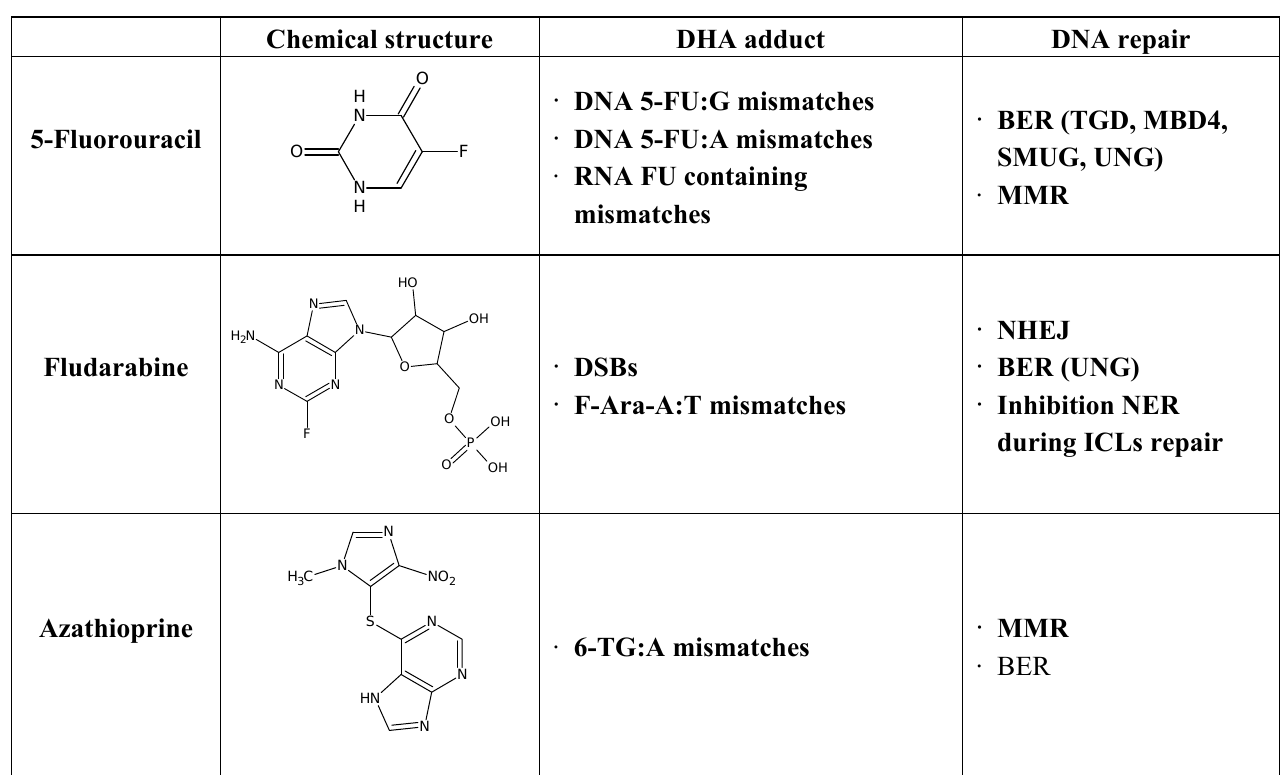
Table 5. Antimetabolites associated with the risk of occurrence of